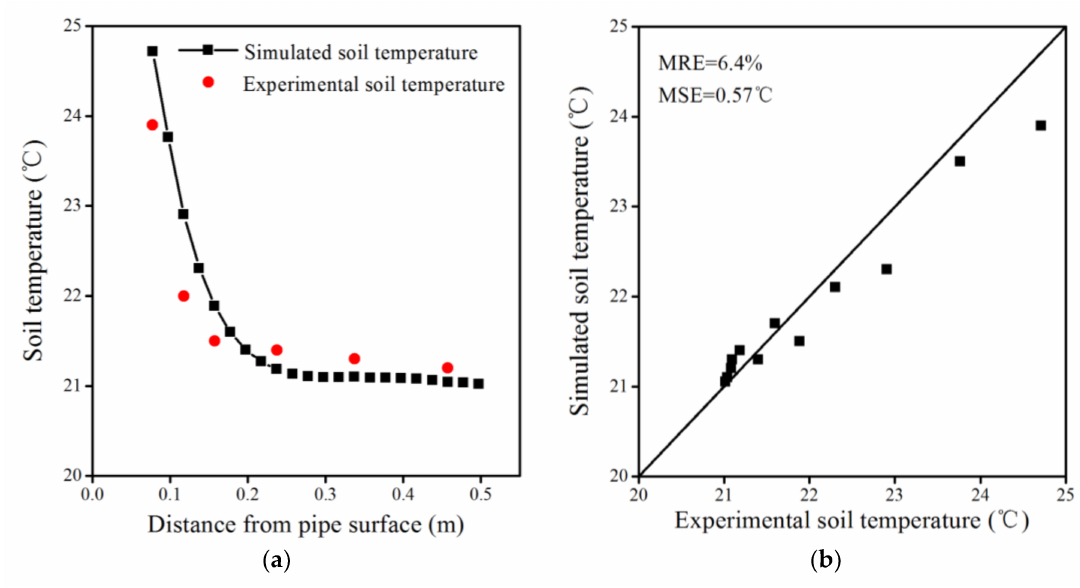
Figure 8. Comparison of the soil temperature in the radial direction. ( a ) comparison of testing and simulated data ( b ) error analysis of testing and simulated